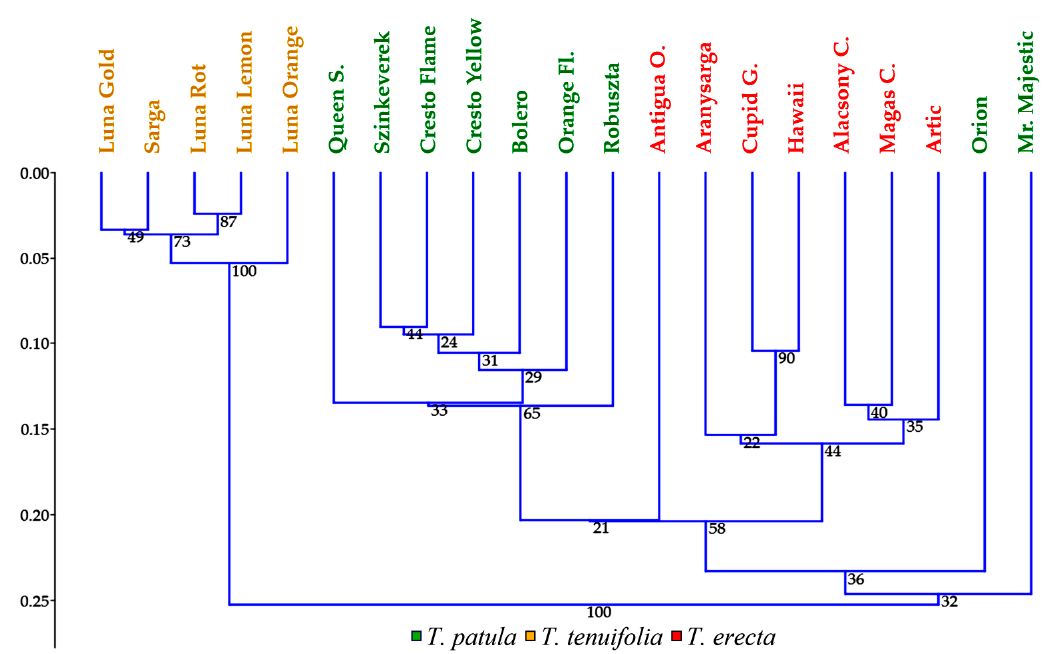
Figure 7. Hierarchical clustering analyses of the 21 cultivars belonging to three Tagetes species based on 20 morphological traits; single linkage method, Gover similarity index.